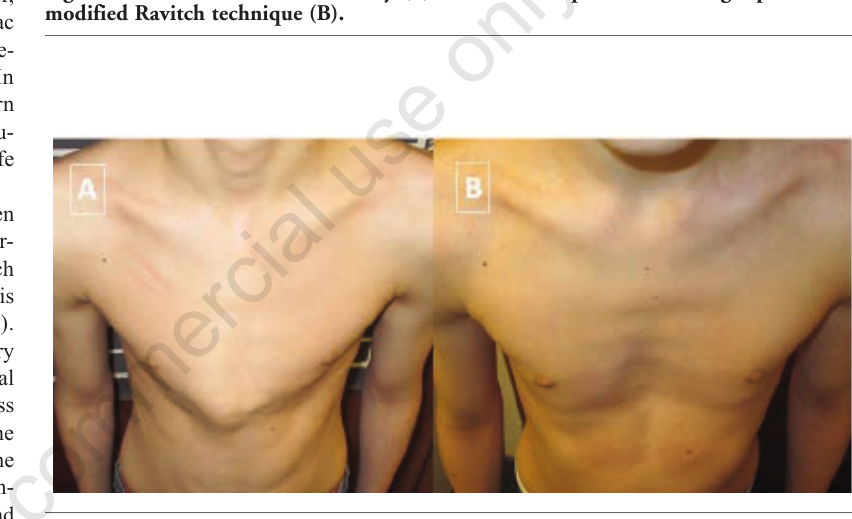
Figure 8. A central pectus carinatum deformity prior to intervention (A) and four months after manipulation and continuous external bracing (B).